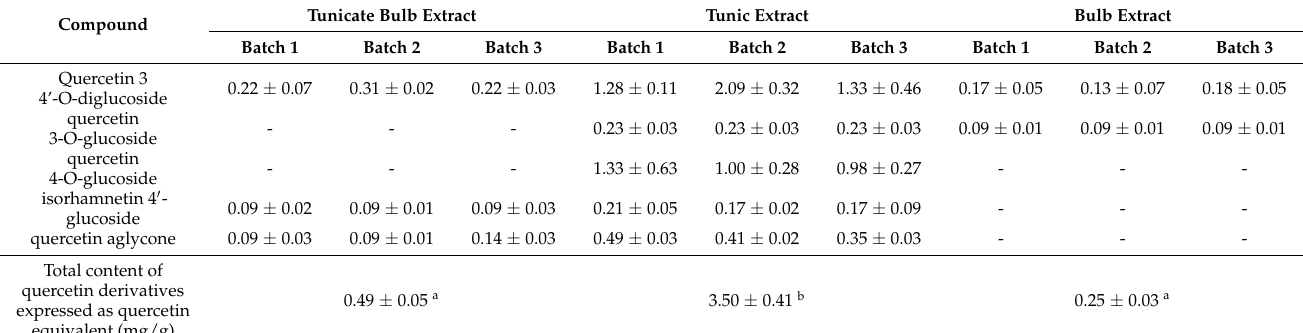
Table 3. Concentrations of quercetin derivatives (expressed as mg of quercetin aglycone/g of ex- tract) in three different batches (batch 1, 2, and 3) of A. cepa Golden variety bulb, tunicate bulb, and tunic extracts and mean of the total content of quercetin derivatives expressed as quercetin equiva- lent.